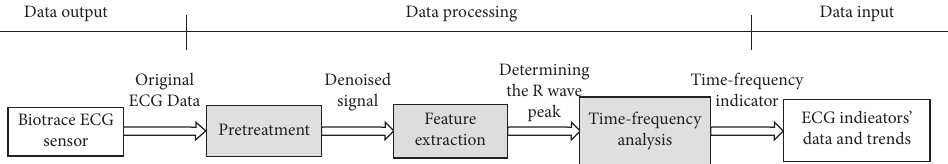
Figure 11: Theanalysis flow diagram of ECG